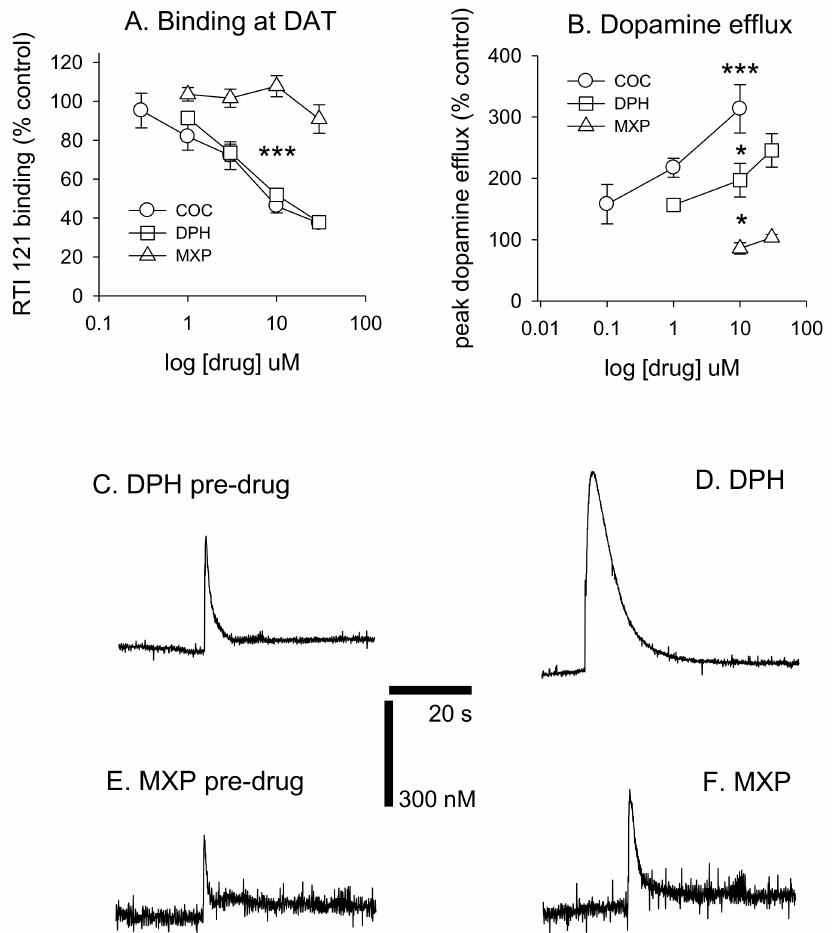
Figure 4. Top panel ( A,B ): Comparative effects of DPH, 2-MXP (MXP) and cocaine-quantitative in vitro data: ( A ) Specific DAT binding expressed as % of [ 125 I]RTI-121 binding; n = 6 per drug concentration. ( B ) peak DA efflux as measured by means of fast cycling voltammetry n = 4–7. Bottom panels ( C – F ): Representative dopamine efflux events after brief electrical stimulation for DPH and 2-MXP (10 pulses at 100 Hz). ( C , E ) show control dopamine efflux prior to drug application. ( D , F ) show dopamine efflux 60 min after drug administration. 60 s of data is shown for each trace and peak dopamine efflux is ~250 nM under control conditions. DAT: dopamine transporter; COC: cocaine; DPH: diphenidine; MXP: methoxyphenidine. Values are means ± SEM. Panel A: *** p < 0.001 for both COC and DPH vs. MXP at 10 µ M. Panel B: * p < 0.05 for COC vs. DPH and for DPH vs. MXP, *** p < 0.001 for COC vs. MXP, all for 10 µ M drug concentrations. For drug concentrations vs. control statistics see